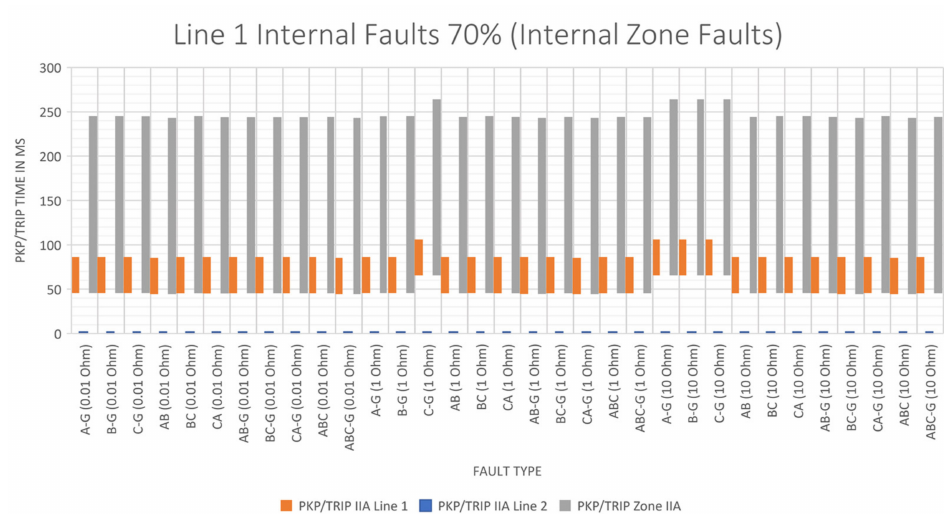
Figure 27. Internal line faults in Line 1 (70%); two